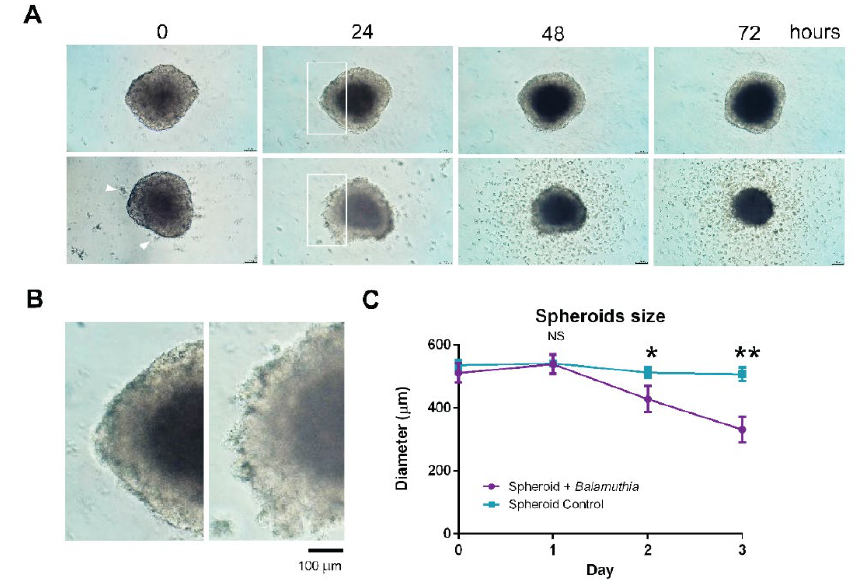
Figure 2. Coculture of neurospheroid with B. mandrillaris trophozoites. ( A ) Optical phase contrast images of SH-SY5Y neurospheroids without or with B. mandrillaris trophozoites (upper and lower panels, respectively). Scale bar = 200 µm. ( B ) Magnified insets of Figure 2A. Left panel = neurospheroid without B. mandrillaris trophozoites (control); Right panel = neurospheroid with B. mandrillaris trophozoites (test). ( C ) Diameter of the neurospheroid at different periods of the coculture. Data are expressed as the mean ± standard deviation of the mean (SD) calculated from six spheroids ( n = 6) for the control and the test. The statistical test: * p < 0.01, ** p < 0.001; NS: not significant.